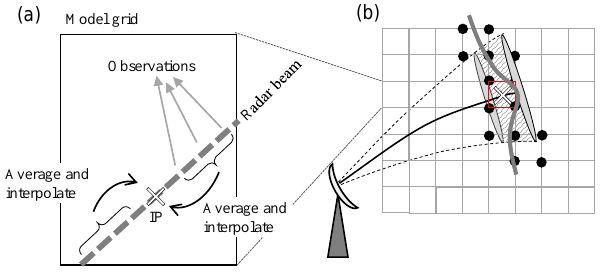
Figure 1. Schematic diagrams of (a) a super observation and (b) the space interpolator. Boxes represent model grid cells, and the red box indicates the grid cell in which the super observation is defined. The cross marks represent the interpolation point (IP). In panel (b) , the grey curve indicates the Gaussian weights at various grid points (black circles), the solid black line shows the beam propagation, and the dashed lines illustrate beam